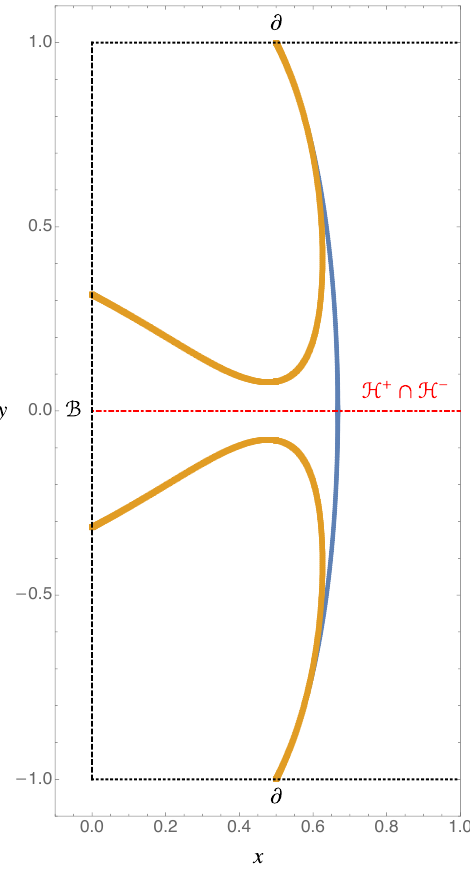
Figure 5: The two types of extremal surfaces, computed numerically at t = 0 in the background geometry found numerically in section 3. In this figure, we have taken θ = π/ 4 and x = 1 / 2. The horizontal black dotted lines ∂ at the top and bottom are ∂ the left and right baths. The dashed black line B along the left edge is the location of the brane, which contains the 4d black hole. The horizontal red dashed-dotted line in the middle is the 5d bifurcate horizon, which meets the brane at the 4d horizon. Compare with figure 2. The orange curve corresponds to an extremal surface ending on the brane with y B ≈ 0.31602 ( 1 ) , while the blue curve correspond to an extremal surface that penetrates the bifurcating Killing surface smoothly. There is, in fact, a continuous family of orange extremal surfaces and there is a unique one amongst them with the smallest area, see figure